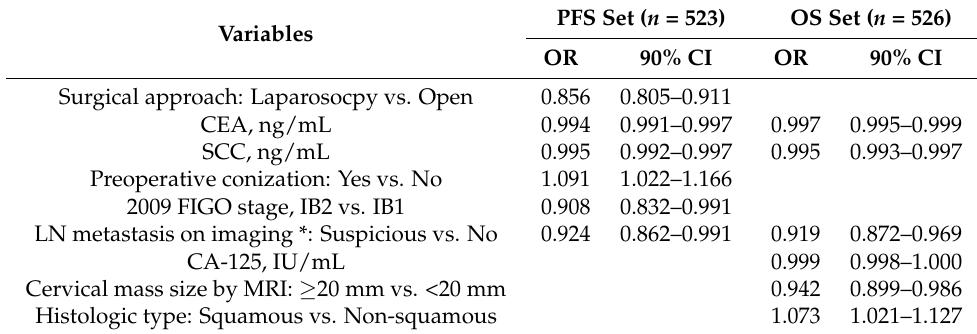
Table 2. Summary of the selected variables using exhaustive variable selection methods.